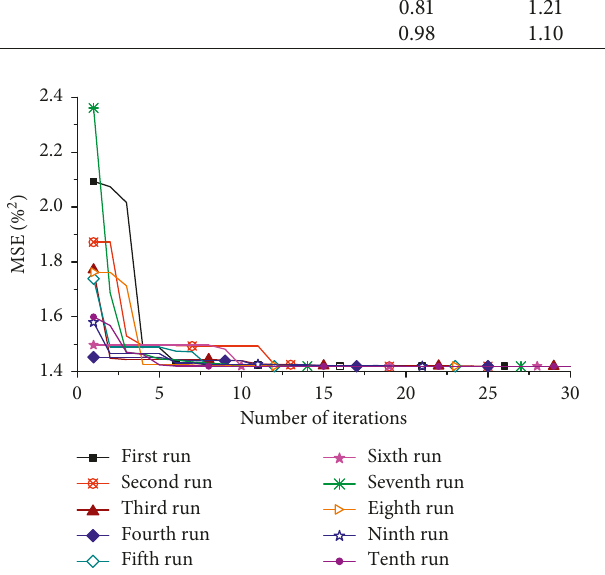
Table 2: Results of the GS-LS-SVM models for the prediction of SSC in different maturation stages of jujube samples over the full spectral range. Prediction set White-mature Crisp-mature Overall